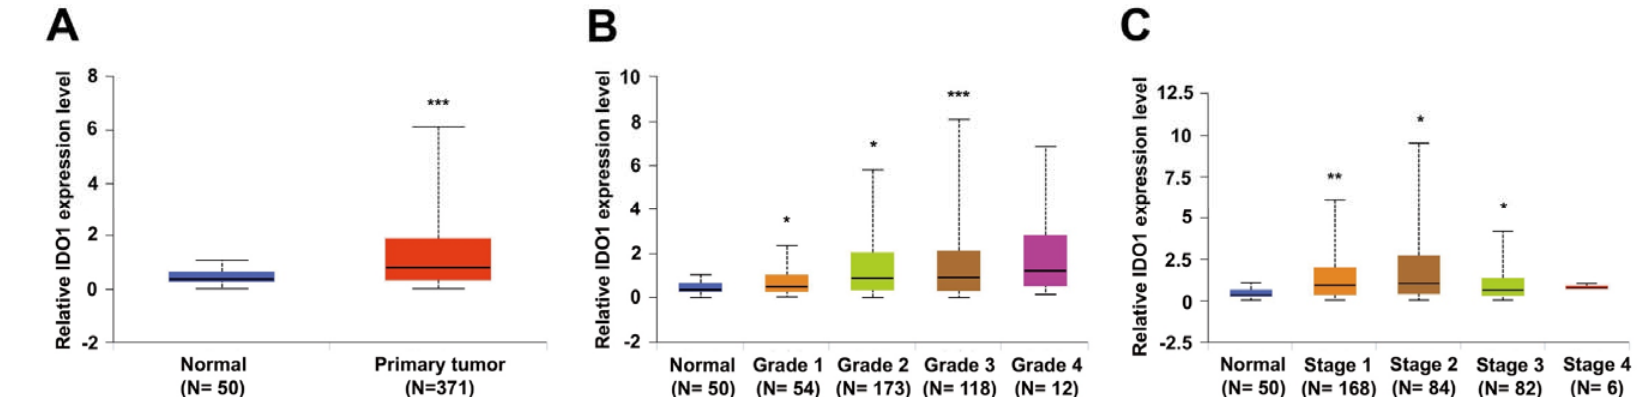
Figure 1. IDO1 expression is significantly elevated in HCC patients. Relative expression levels of IDO1 were compared between HCC tumor and normal tissues based on analysis of a liver hepatocellular carcinoma (LIHC) cohort obtained from the TCGA database via UALCAN platform. Groups were further stratified according to ( A ) sample type, ( B ) individual tumor grade, and ( C ) individual cancer stage (*, p < 0.05; **, p < 0.01; ***, p < 0.001).